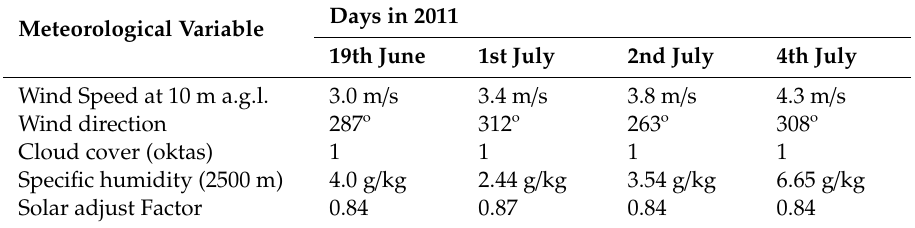
Figure 1. Hourly evolution of air temperature and relative humidity (forcing conditions for the model), measured at the Deusto station. Table 4. Description of the model meteorological boundary configuration of each day of